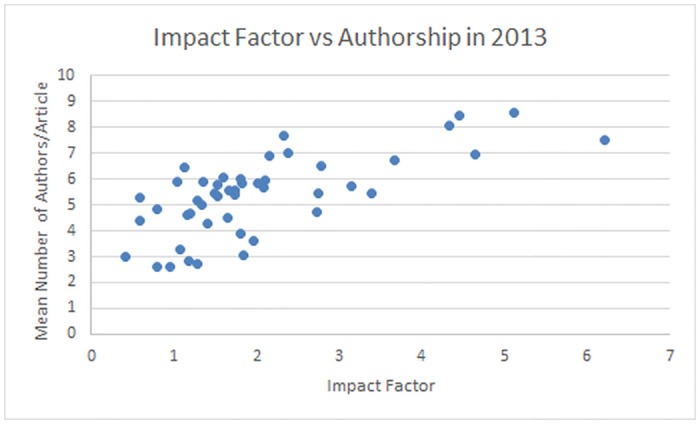
Relationship between Impact Factor and Average Authorship in 2013.The 2013 impact factor of journals analyzed compared against the average number of authors/article in 2013. JBR-TBR and Journal of Radiology Case Reports were excluded from this graph as they did not have a 2013 impact factor.